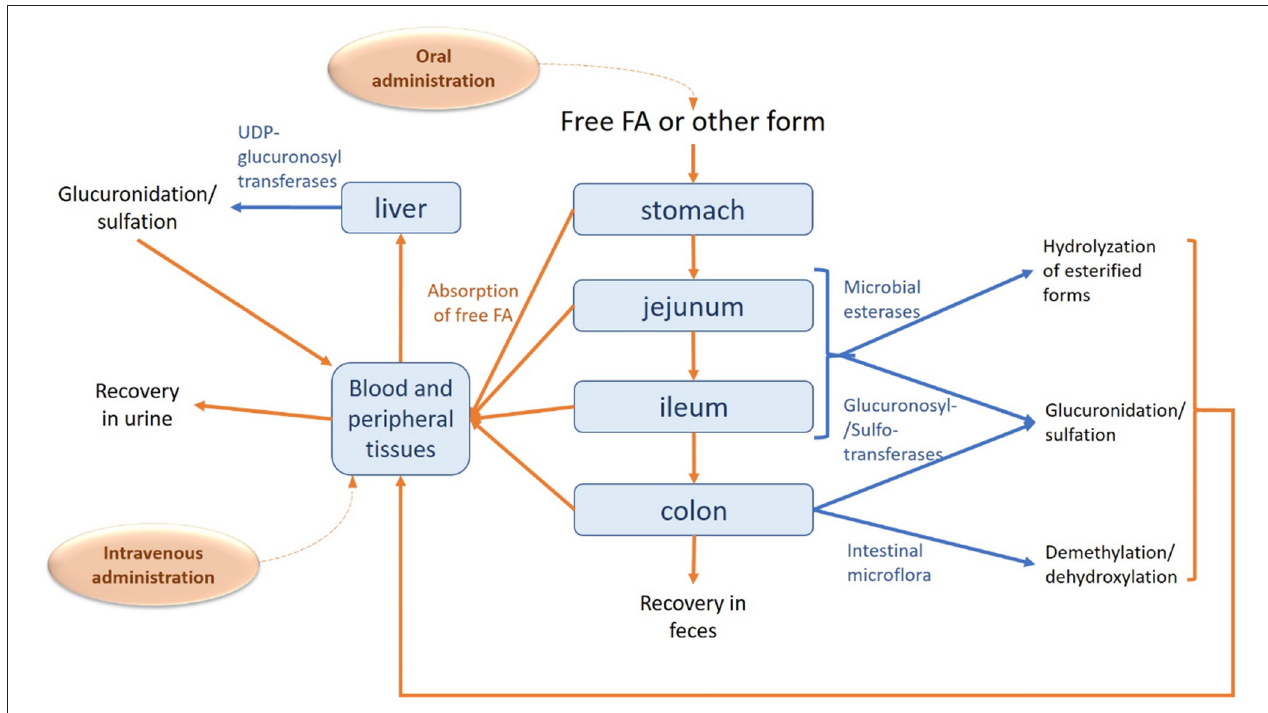
FIGURE 2 | Absorption, metabolism and excretion of FA in human body. The route of FA is described with orange arrows, while the metabolic modifications are shown in blue.